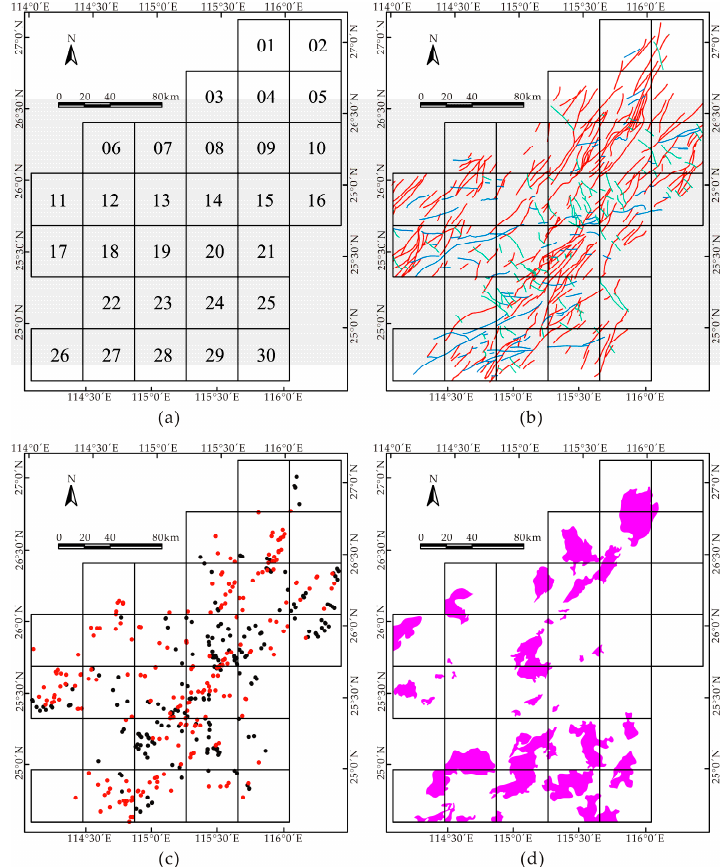
Figure 2. Extracted geological features in 30 subregions under fractal analysis: ( a ) location and ID of each subregion; ( b ) regional faults, including NE–NNE-trending faults marked in red, EW-trending faults marked in blue, and NW–NNW faults marked in green; ( c ) fault intersections, of which the intersections of NE–NNE- and EW-trending faults are marked in red; and ( d ) Yashanian granites.